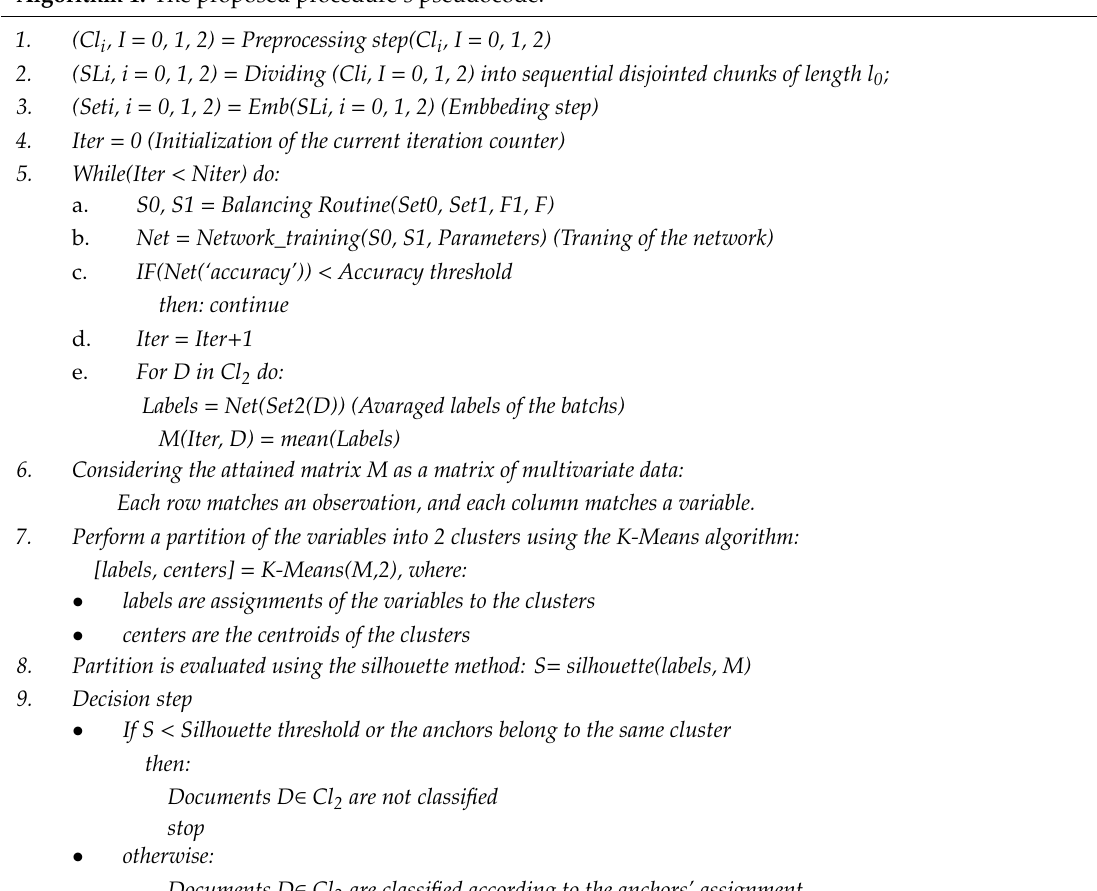
Algorithm 1. The proposed procedure’s